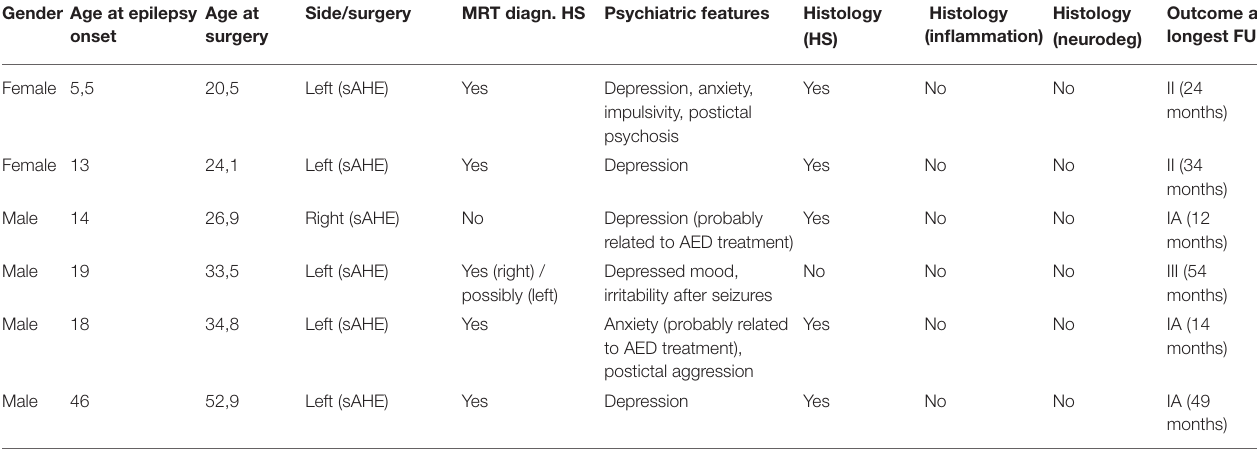
TABLE 2 | Clinical characteristics of patients undergoing temporal lobe surgery without limbic encephalitis and without an early inciting event (control group). Gender Age at epilepsy onset